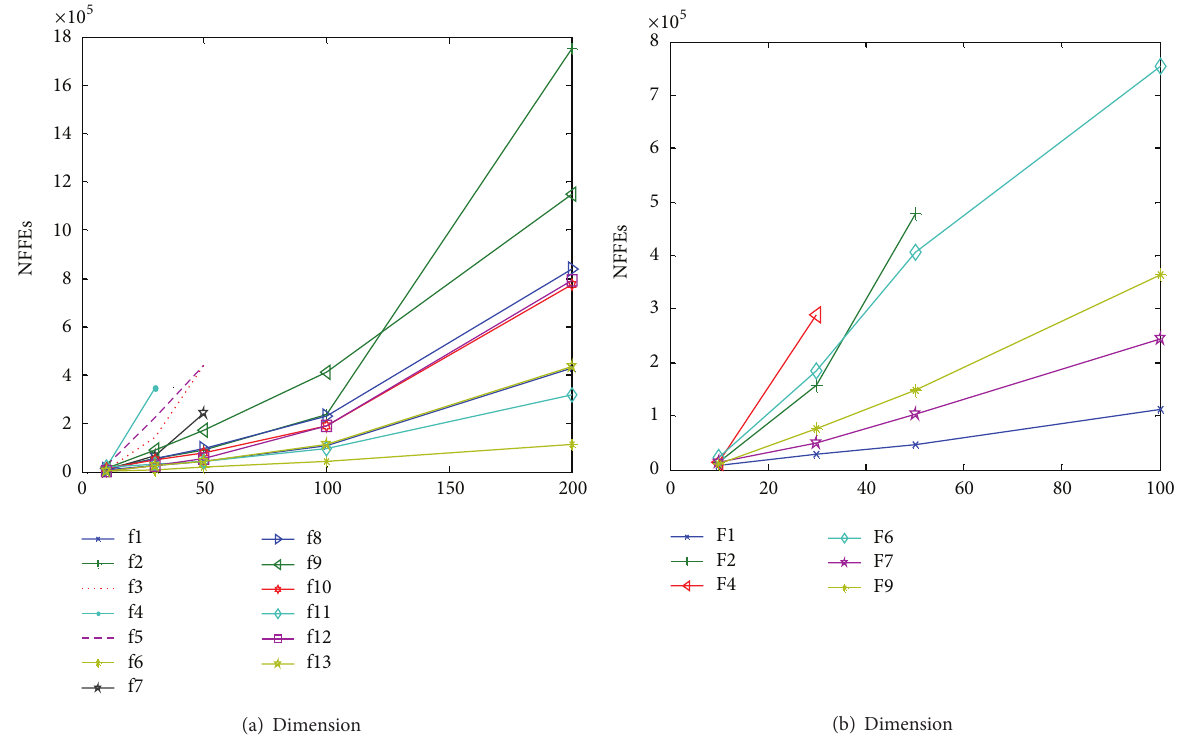
Figure 7: NFFEs versus dimensions for (a) standard functions and (b) CEC 2005 functions.